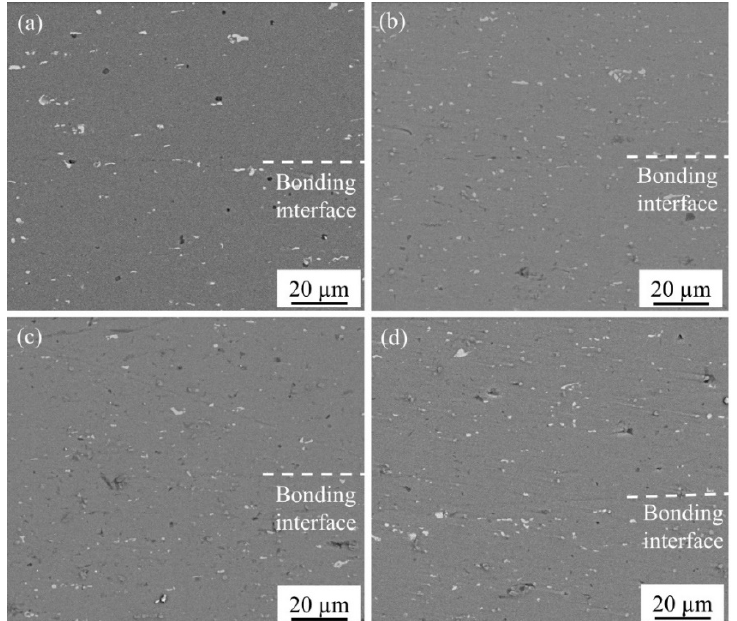
Figure 5. Microstructures of AA6061/AA6061 bonding interfaces after diffusion bonding at ( a ) 500 °C, ( b ) 510 °C, ( c ) 520 °C, and ( d ) 530 °C for 240 min. ( b ) 510 ◦ C, ( c ) 520 ◦ C, and ( d ) 530 ◦ C for 240